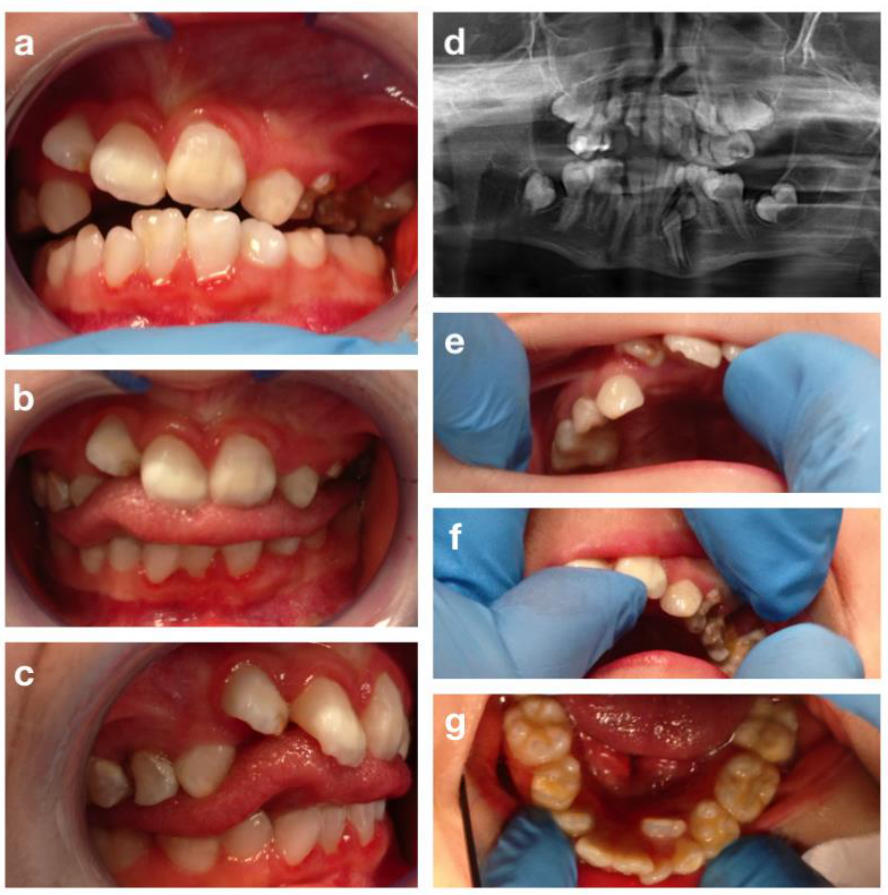
Figure 6. The Cornelia de Lange syndrome: intra-oral pictures ( a – c , e – g ) and orthopantomography ( d